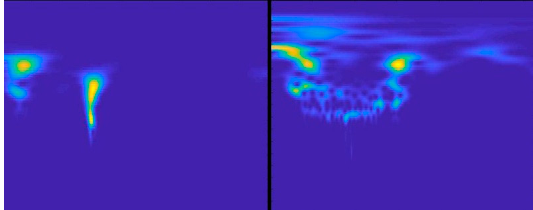
Figure 3. Images of a normal and abnormal scalogram retrieved from the PASCAL database.